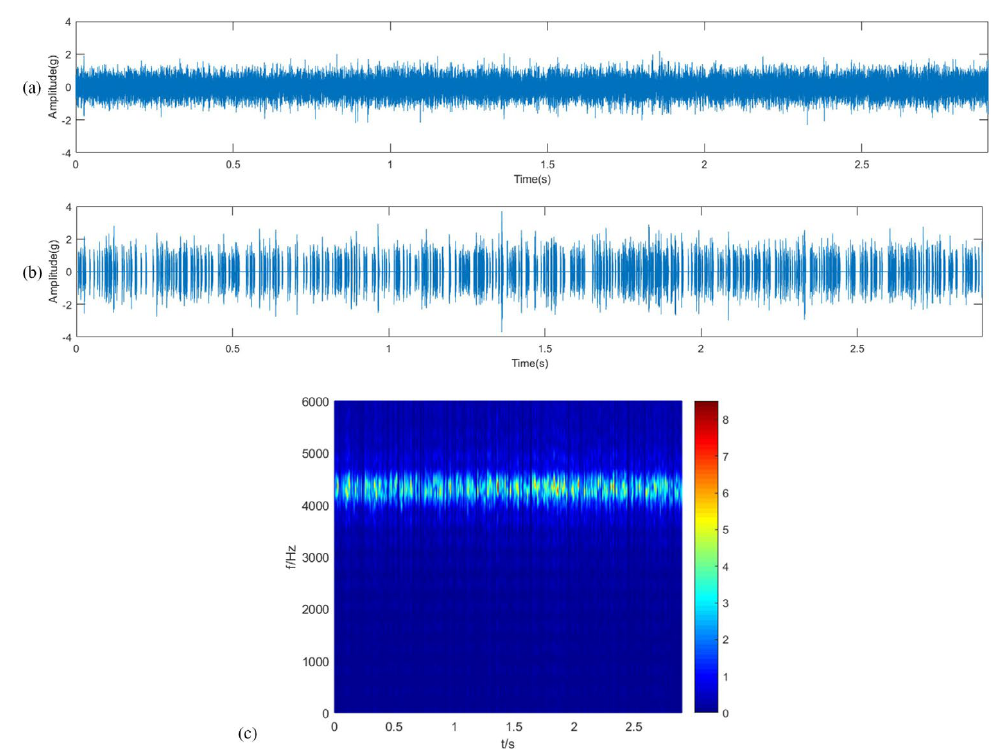
Figure 11. In 25 h: ( a ) Raw vibration signals; ( b ) reconstructed component; ( c ) the STFT of impulse component.